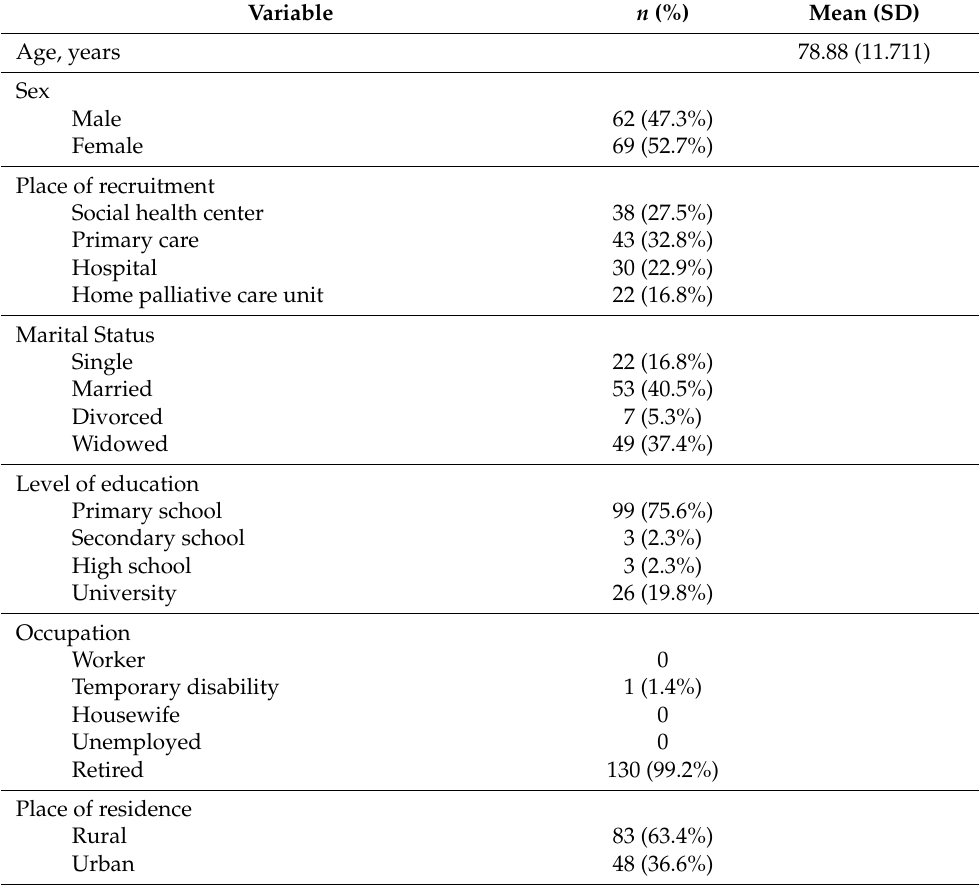
Table 1. Characteristics of the sample.